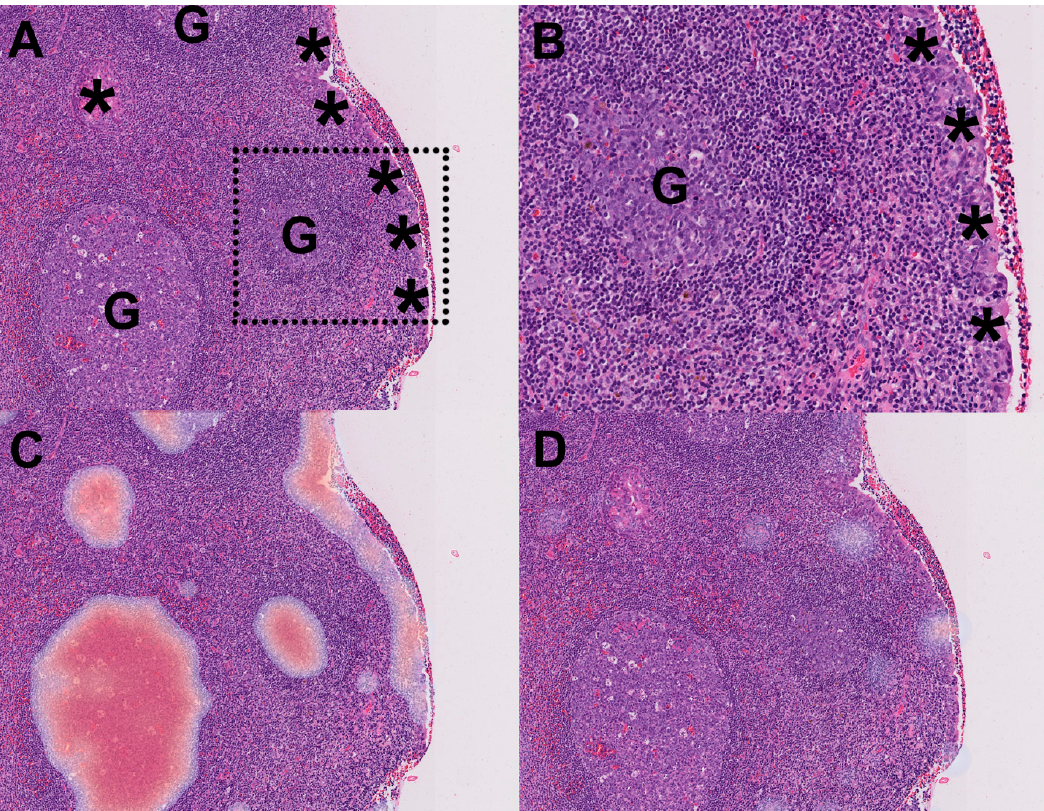
Figure 1. Expansion of the training data successfully prevented misclassification of patches. ( A ) An example of benign nasopharyngeal tissue in our testing set, with prominent germinal centers (G) and benign epithelial cells (asterisks) (original magnification ×40). ( B ) A magnified inset of ( A ) (dotted square). ( C ) The original patch-level model misclassified regions of germinal centers and benign epithelial cells as nasopharyngeal carcinoma (red color: high probability). ( D ) The performance of the model was markedly improved after expanding the training data with germinal centers and benign epithelial cells. Cancers 2020 , 12 , x FOR PEER REVIEW